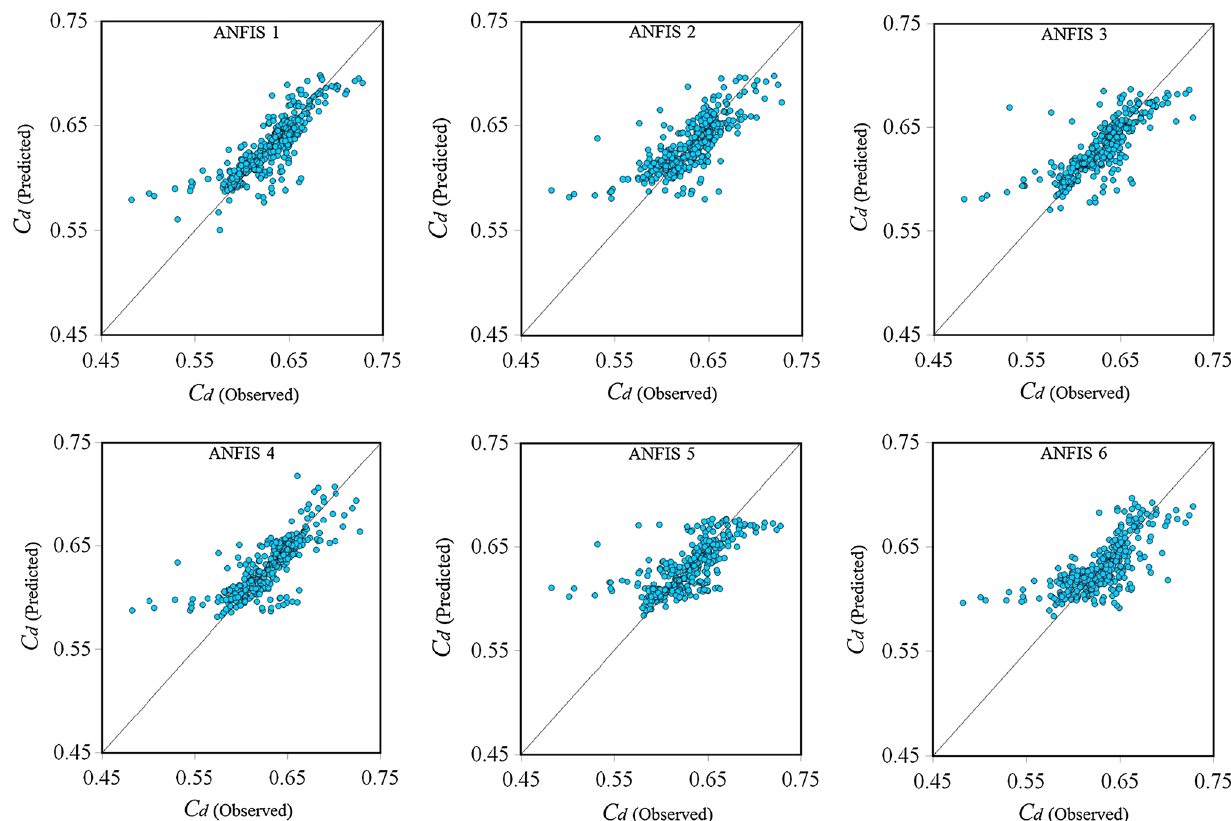
Fig. 10 Scatter plots for six ANFIS models